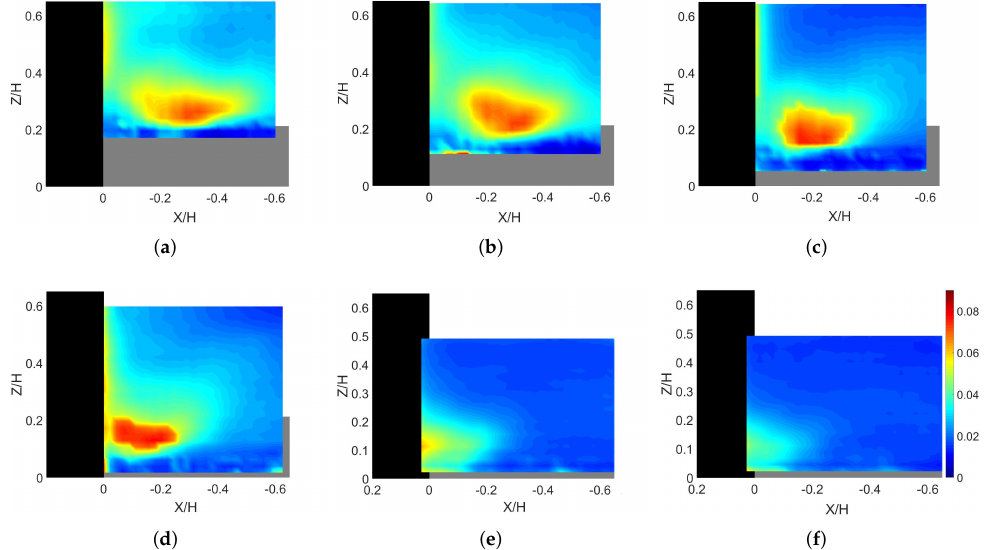
Figure 15. Distribution of TKE* within the representative vertical sections, parallel to the main flow direction, ( a – d ) over the channel bank and ( e , f ) within the main channel. The location of the sections parallel to the main flow direction shown here was defined in Figure